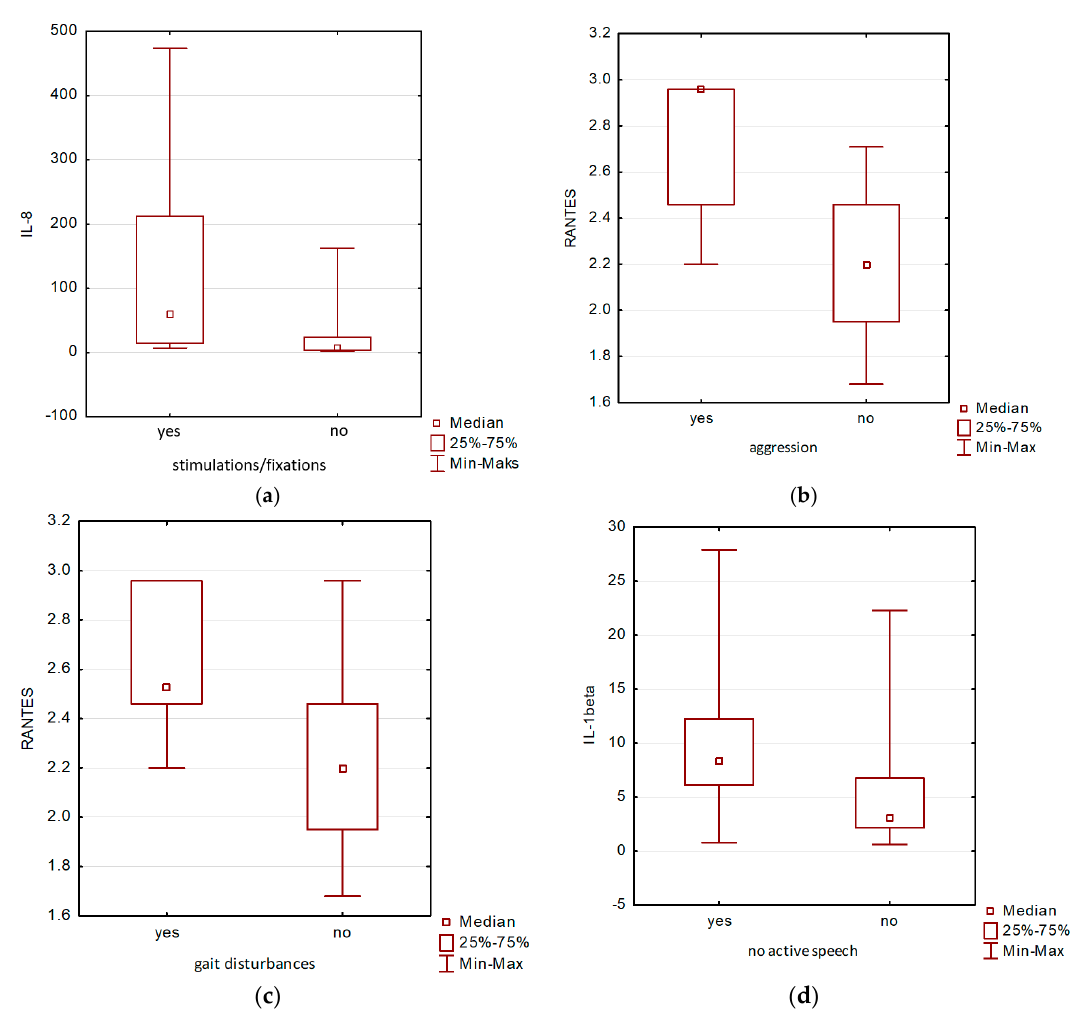
Figure 2. ( a–d ). Statistically significant differences between salivary levels of IL-8 and stimulations / fixations (Figure 2a), levels of RANTES and aggression (Figure 2b) and gait disturbances (Figure 2c) and levels of IL-1 β and no active speech (Figure 2d).